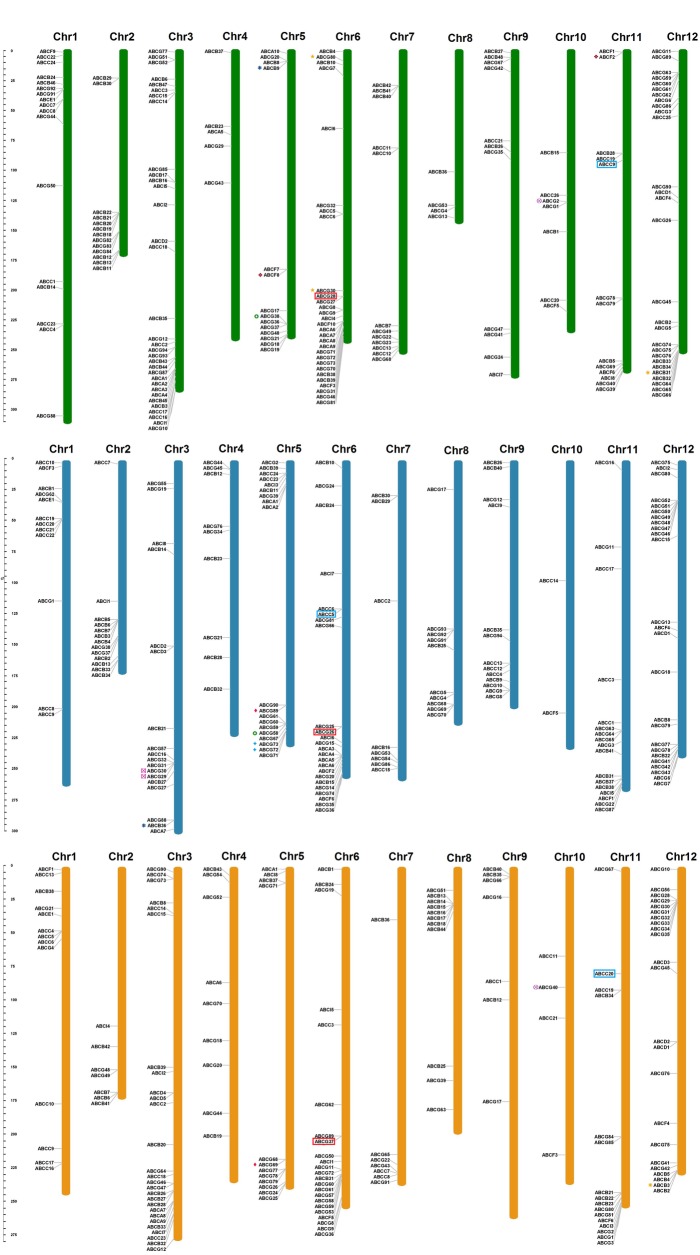
Chromosomal locations of ABC transporter proteins in pepper C. annuum (green), C. baccatum (blue) and C. chinense (orange).Chromosome numbers are represented at the top of each chromosome. The left panel scale indicates the chromosome length in Mb. The paralogous ABC gene pairs are represented with different colors and shapes. Orthologs genes of CA06g14430 and CA11g09150 are represented by red and blue boxes respectively.